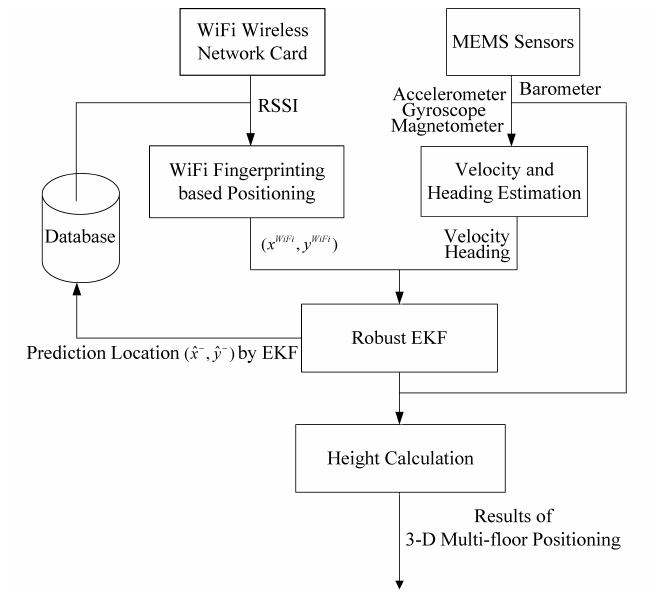
Figure 1. Flow chart of the proposed system.